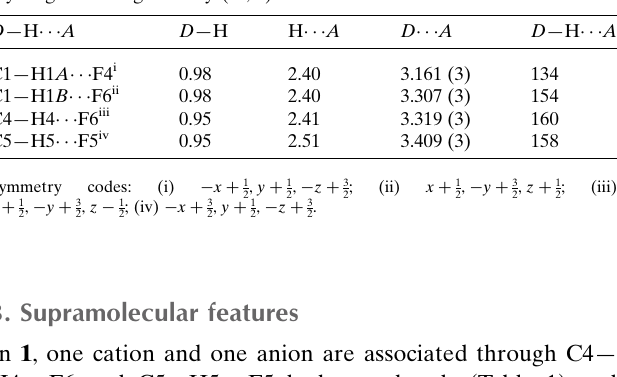
Table 1 Hydrogen-bond geometry (A˚ , (cid:4) ) for 1